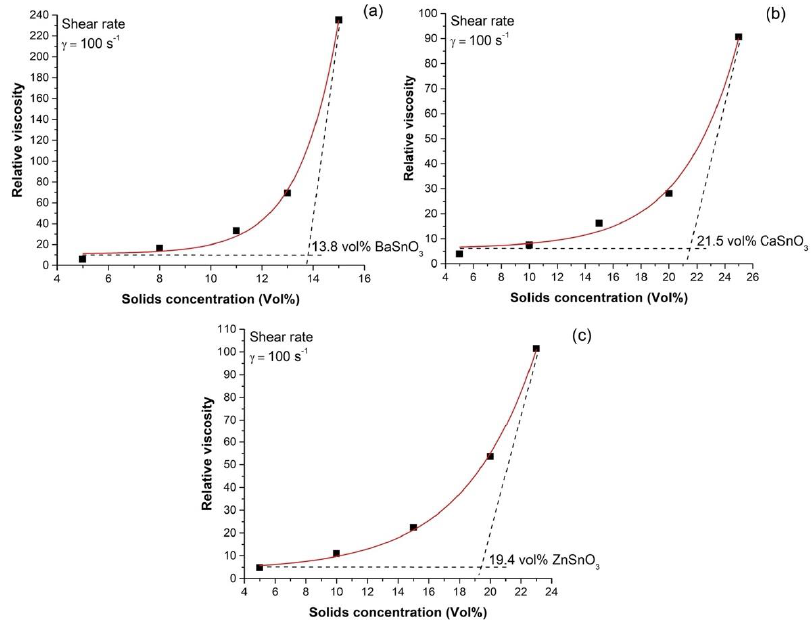
Figure 3. Relative viscosity (𝜂 𝑟 ) as a function of solid content (φ) for the suspensions containing BaSnO 3 ( a ), CaSnO 3 ( b ), and ZnSnO 3 ( c )